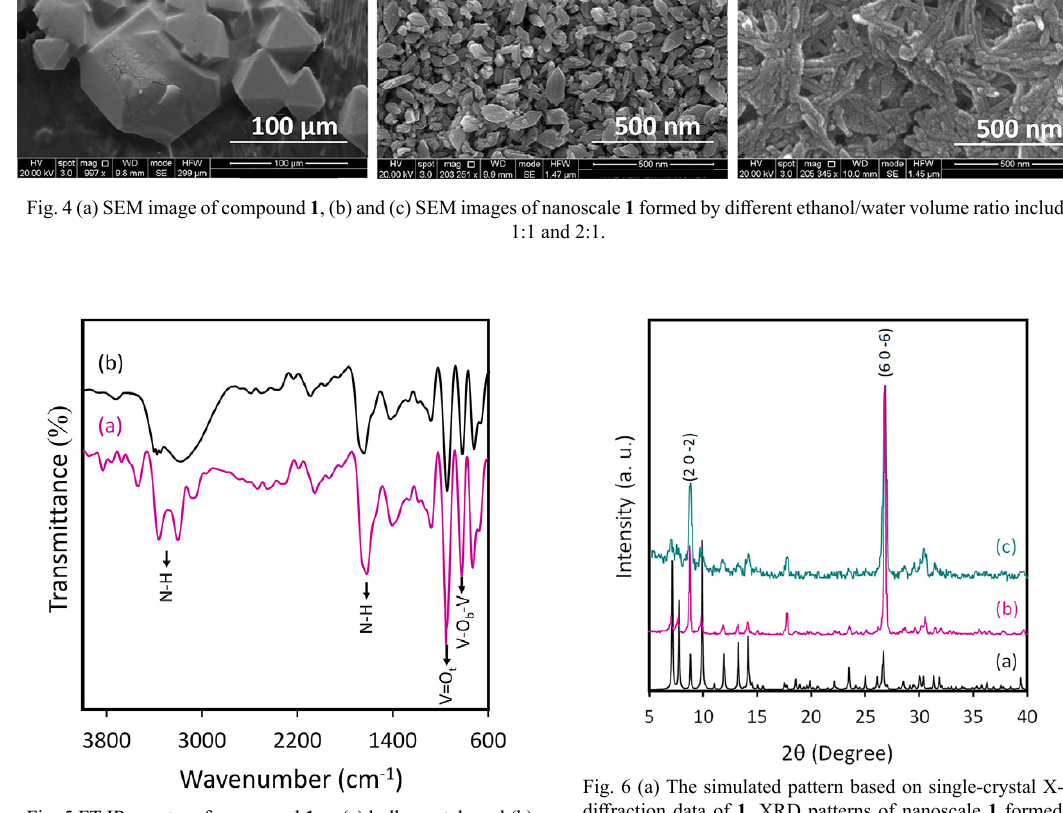
Fig. 5 FT-IR spectra of compound 1 as (a) bulk crystals and (b) nanoparticles produced by sonochemical method.